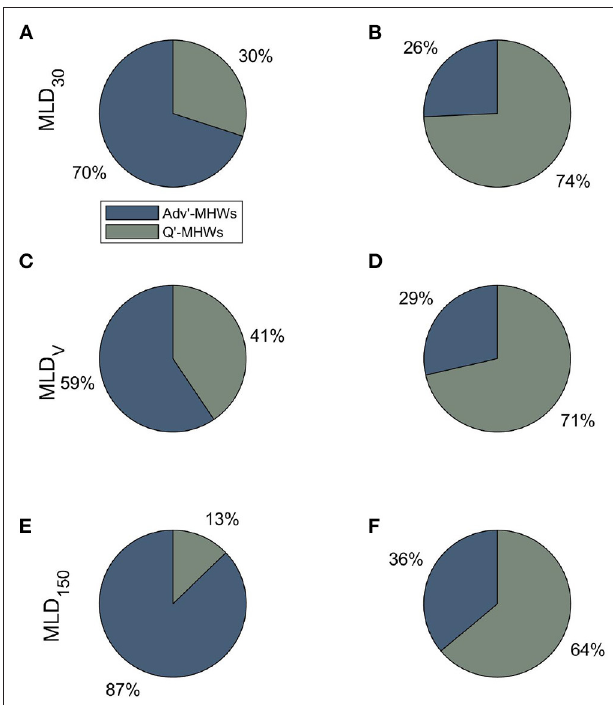
FIGURE 11 | Proportion of Adv’-MHWs (blue) and Q’-MHWs (green) in the Eddy (A,C,E) and NZ (B,D,F) in each of the three SML scenarios as marked by row